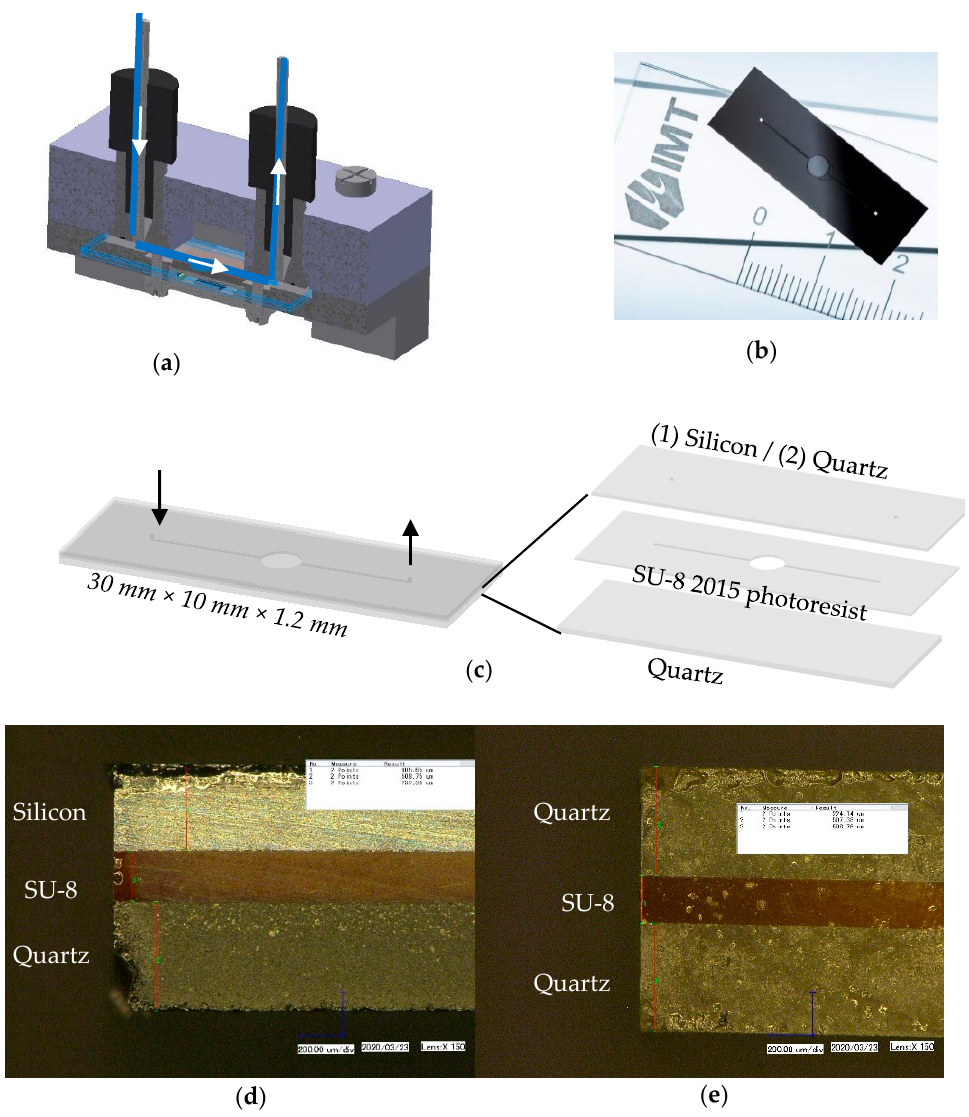
Figure 3. ( a ) Microfluidic circuit of the detection system. ( b ) Fabricated silicon fluidic cell. ( c ) Fluidic